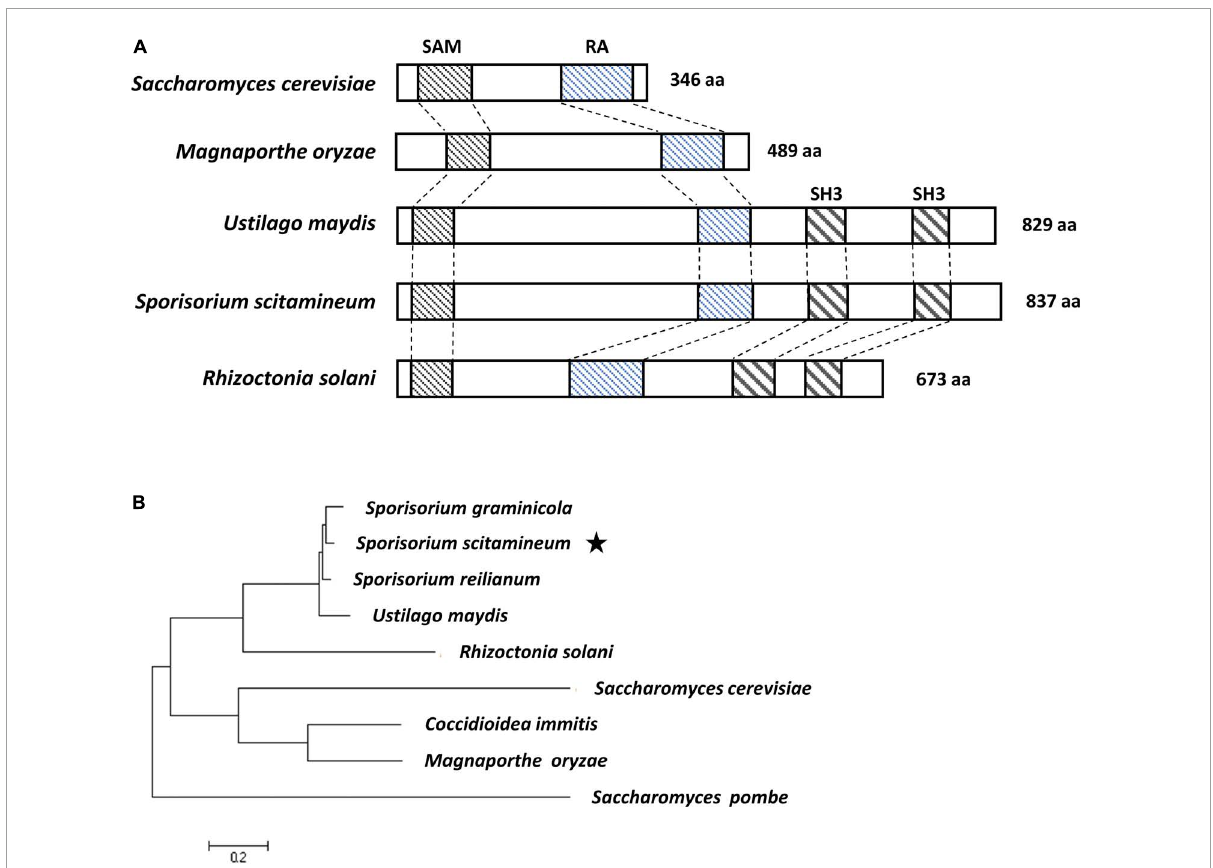
FIGURE1 Sequence analysis of S. scitamineum adaptor protein SsUbc2. (A) Structure of the Ste50 and Ubc2 proteins. Conserved domains of Sterile Alpha Motif (SAM), Ras-Association (RA), and Src Homology 3 (SH3) are in boxes. (B) Phylogenetic tree constructed with amino acid sequences of Ste50 and Ubc2 proteins from ascomycetous and basidiomycetous species. The evolutionary history was inferred using the maximum likelihood method based on the JTT matrix-based model (Jones et al., 1992). Evolutionary analyses were conducted in MEGA7 (Kumar et al., 2016). Accession numbers are CBQ70036.1 for S. reilianum , XP_011391983.1 for U. maydis , XP_029739906.1 for S. graminicola , ELU43665 for Rhizoctonia solani , XP_001239789.2 for Coccidioidea immitis , XP_003712743.1 for M. oryzae , NP_009898.1 for Saccharomyces cerevisiae , and NP_596828.1 for Saccharomyces pombe . The star indicates the position of Ubc2 from Sporisorium scitamineum